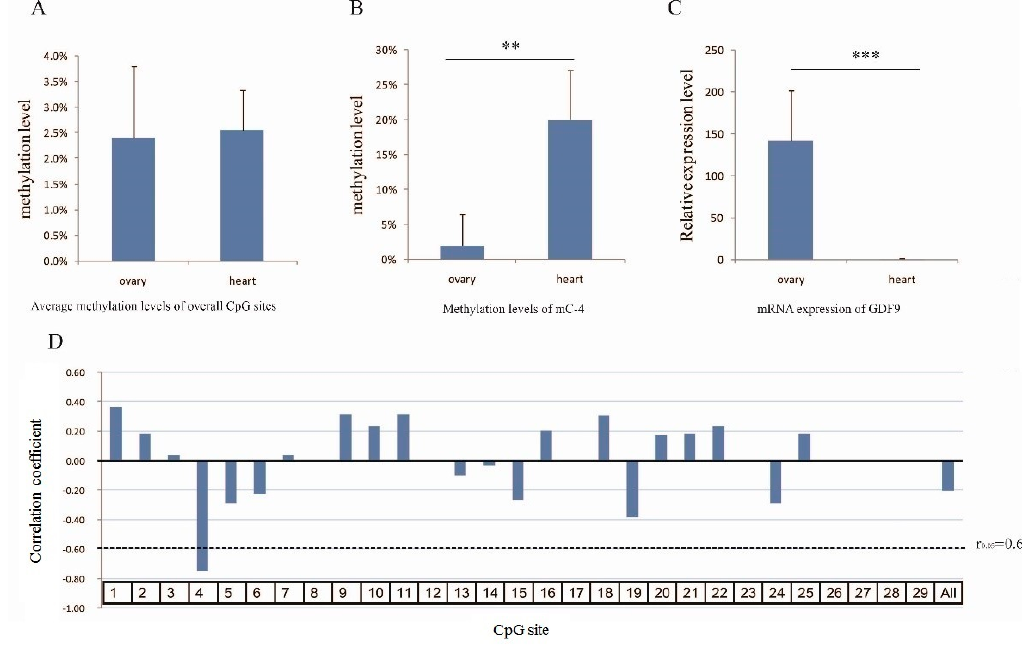
Figure 3. GDF9 mRNA expression and the correlation with methylation level. ( A ) The average methylation level of overall CpG sites, with no significant difference between heart and ovary. ( B ) The methylation level of mC-4 in ovary and heart, significantly lower in ovary than that in heart (** p < 0.01). ( C ) The mRNA expression of GDF9 in ovary and heart, with significantly higher expression in ovary than that in heart (*** p < 0.001). ( D ) Pearson’s correlation coefficient for correlations between mRNA expression and methylation level. mRNA level was significantly correlated with methylation at the mC-4 site. Dashed line (r 0.05 ) represents the correlation coefficient threshold.